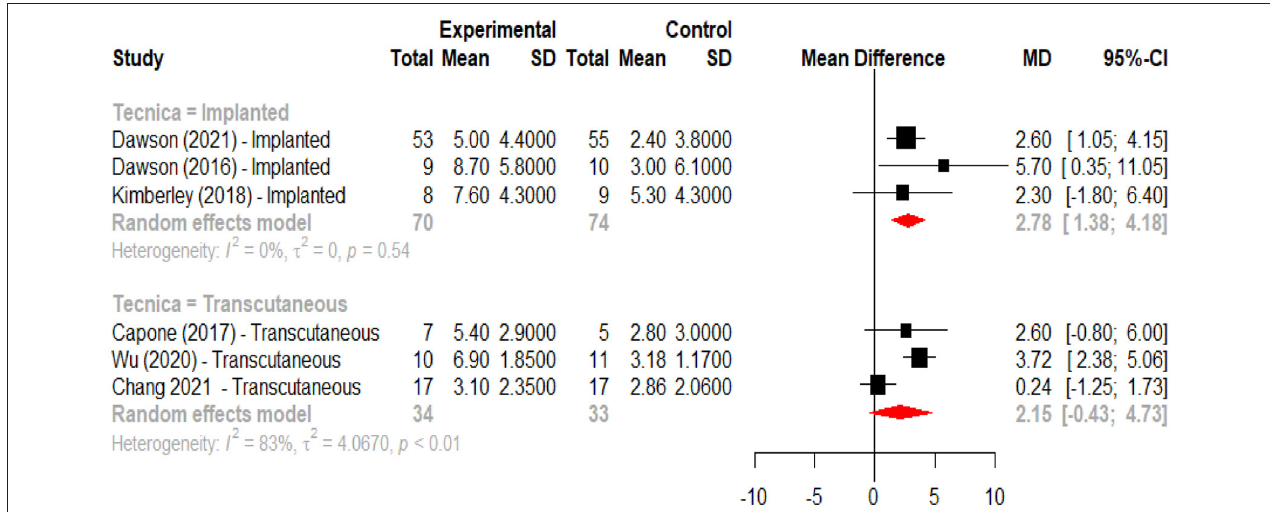
FIGURE 4 | Forest plot for the meta-analysis of vagus nerve stimulation effects on upper limb motor function (FMA-UE score increase) when compared to a control intervention according to intervention modality (implanted vs. transcutaneous).